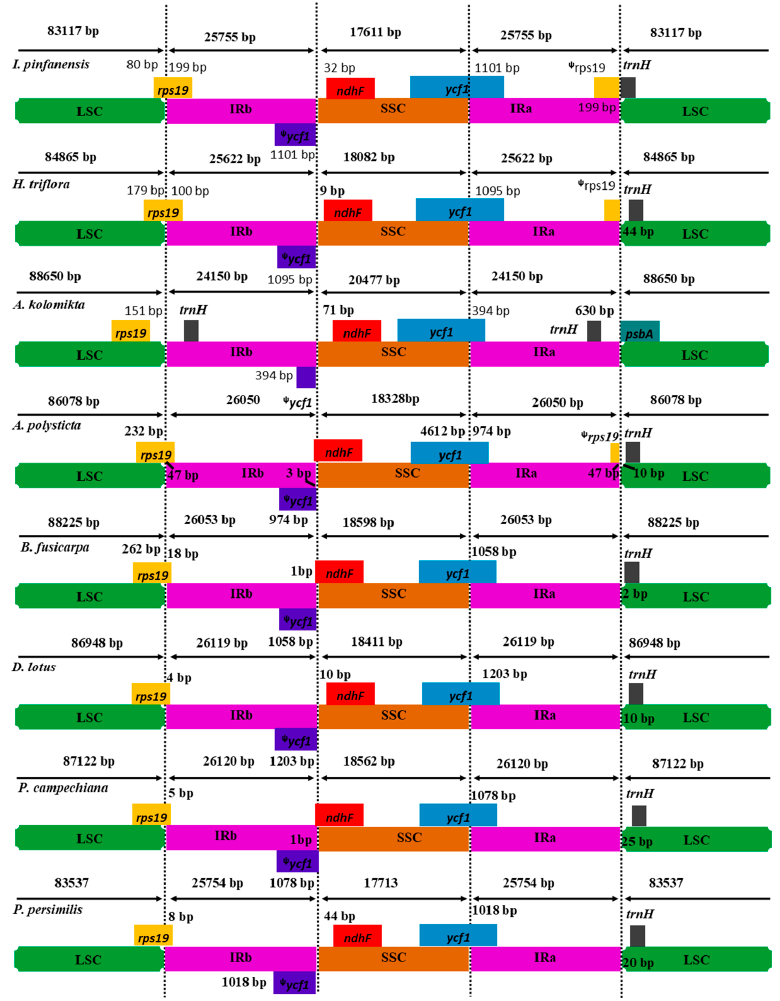
Figure 4. Comparison of IR, LSC and SSC border regions among eight Ericales cp genomes. The IRb/SSC junction extended into the ycf1 genes creating various lengths of ycf1 pseudogenes among the eight cp genomes. The numbers above, below or adjacent to genes shows the distance between the ends of genes and the boundary sites. The figure features are not to scale. (cid:31) indicates a pseudogene. The border regions of the Ericales revealed that the I. pinfanensis and H. triflora cp genomes varied a little compared to other analyzed cp genomes. As shown in Figure 4, our analyses confirmed the IR evolution as revealed by the incomplete rps19 gene, which was duplicated in the IR region in